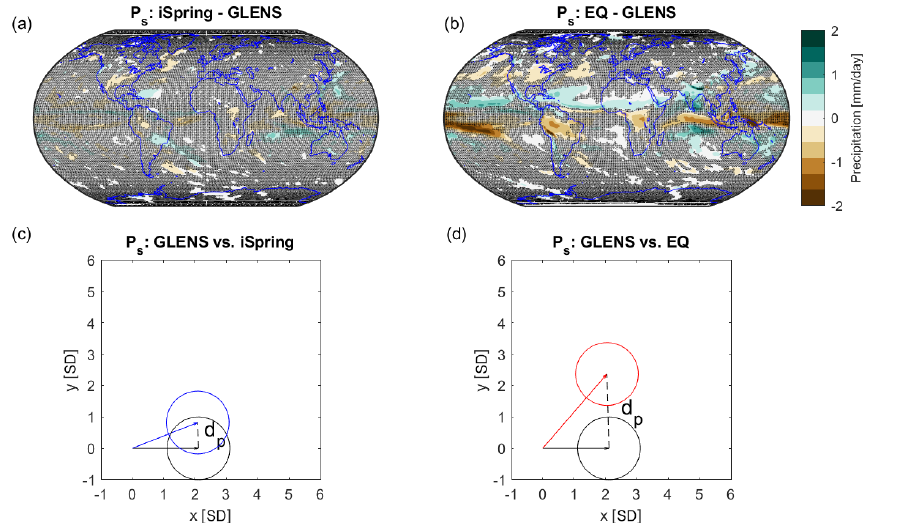
Figure 10. Panels (a, c) show the comparison between GLENS and iSpring; (b, d) show the comparison between GLENS and EQ. Pan- els (a) and (b) show the difference in precipitation responses between GLENS and iSpring and between GLENS and EQ, respectively; shaded areas are where no statistically significant difference is observed, based on a t test with a confidence level of 95%. Panels (c) and (d) are detectability plots that geometrically show the ability of detecting differences in the precipitation responses between GLENS (black) and iSpring (blue) and between GLENS and EQ (red), respectively. The precipitation responses are expressed in the number of SDs of 20-year averages of precipitation. Both the x and y axes are distances in the number of standard deviations. The length of each vector represents the area-weighted L 2 norm of precipitation response, and the circle represents precipitation variability in all possible directions, with a radius of 1SD due to the normalization. The dashed line in panels (c) and (d) measures the precipitation distance, d p , between GLENS and iSpring and between GLENS and EQ, respectively. Similar to temperature response, the difference in precipitation between GLENS and EQ is more detectable than that between GLENS and iSpring at the same level of